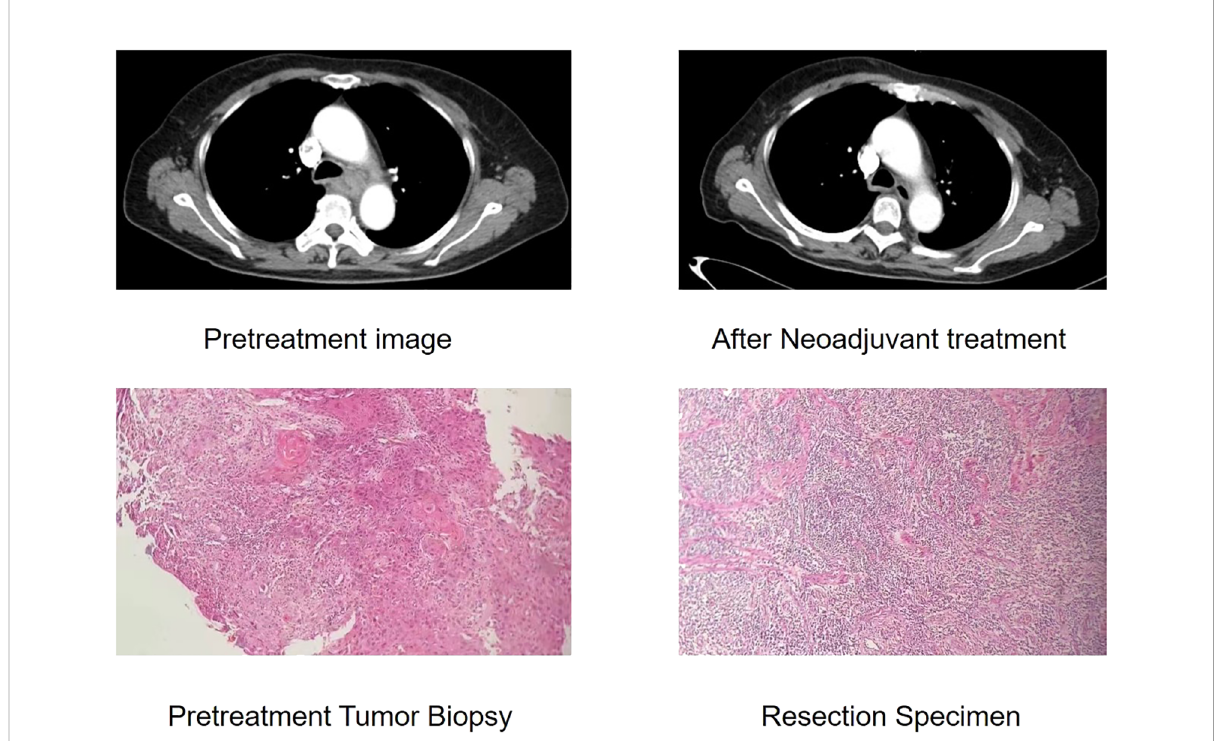
FIGURE 2 Case of radiological and pathological responses after neoadjuvant immunotherapy plus chemotherapy. This shows the radiological and pathological images of a 61-year-old male with a stage III(cTNM)ESCC before neoadjuvant treatment. The CT image shows insigni fi cant